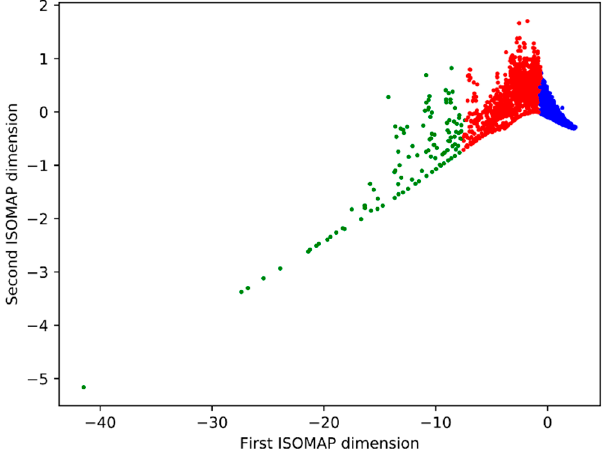
Figure 14. Projection of the six-dimensional feature data to two dimensions using the isomap algorithm Clusters defined by the clustering process, blue—keratinocyte-like cells, red—fibroblast-like cells, green—conglomerates of multiple cells.